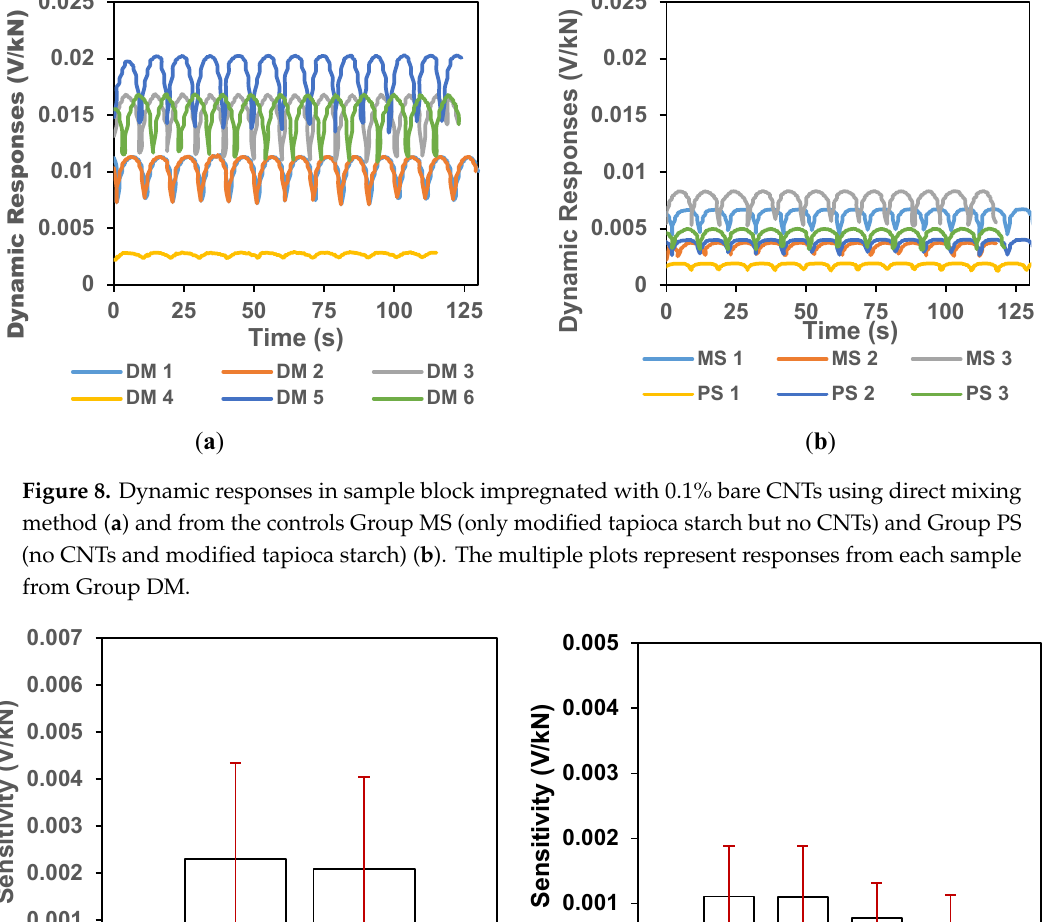
Figure 7. ( a ) Dynamic load responses in sample blocks impregnated with 0.1% SM-CNTs. The multiple plots represent responses from each sample from group SM; ( b ) Average loading and unloading sensitivities in sample blocks impregnated with 0.1% CCNTs. The vertical error bars represent the standard deviations.